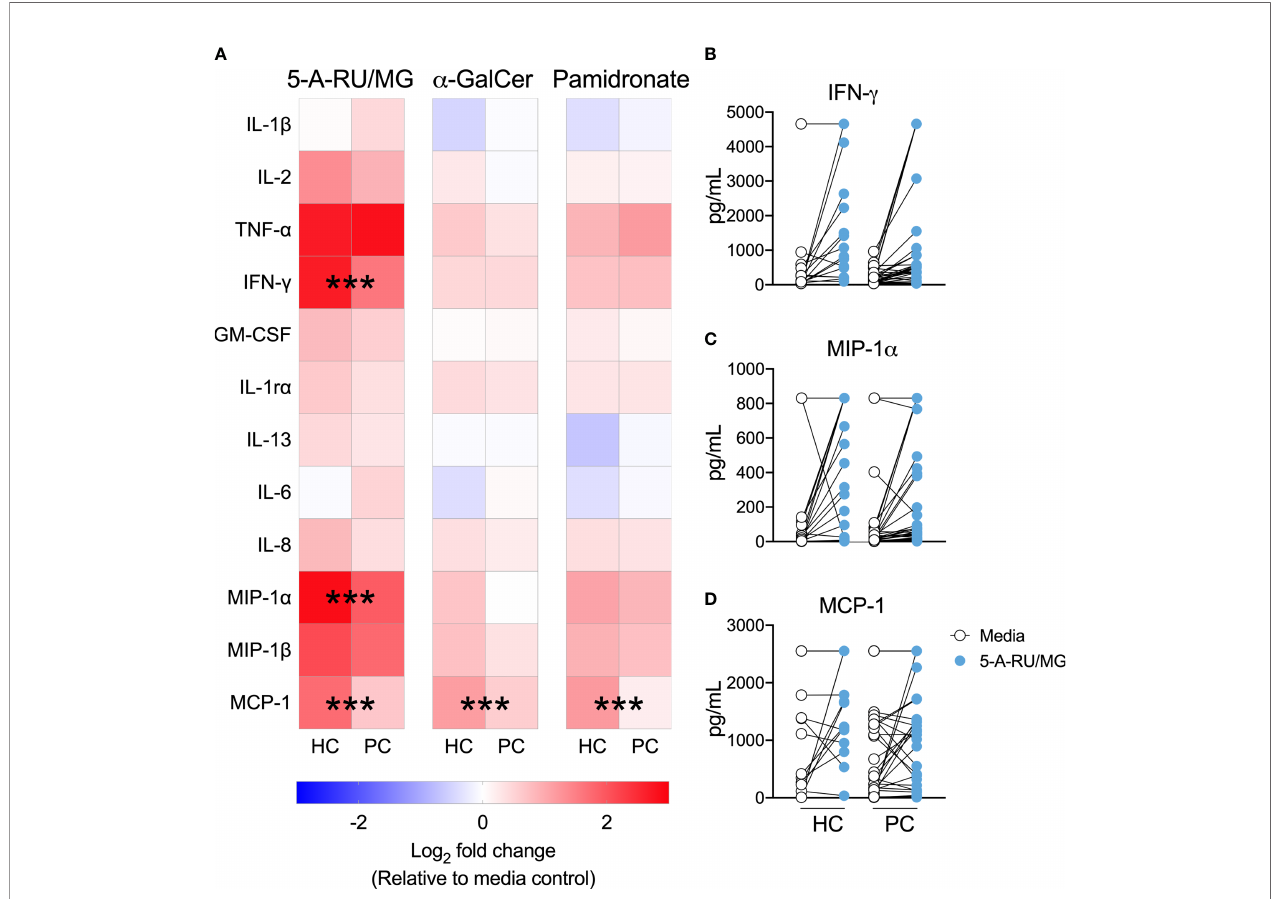
FIGURE 3 | MAIT-cell agonist induced cytokines are impaired in men with prostate cancer. Culture supernatant was aspirated after 72 hours from the above proliferation assay and the Log 2 fold change in cytokines above media control is displayed (A) . Multiple t-test. Individual plots quantifying IFN- (B) , MIP-1 a (C) and MCP-1 (D) in 5-A-RU/MG stimulated and media control samples are also displayed. ***P < 0.001. N = 18 healthy controls (HC), 36 men with prostate cancer